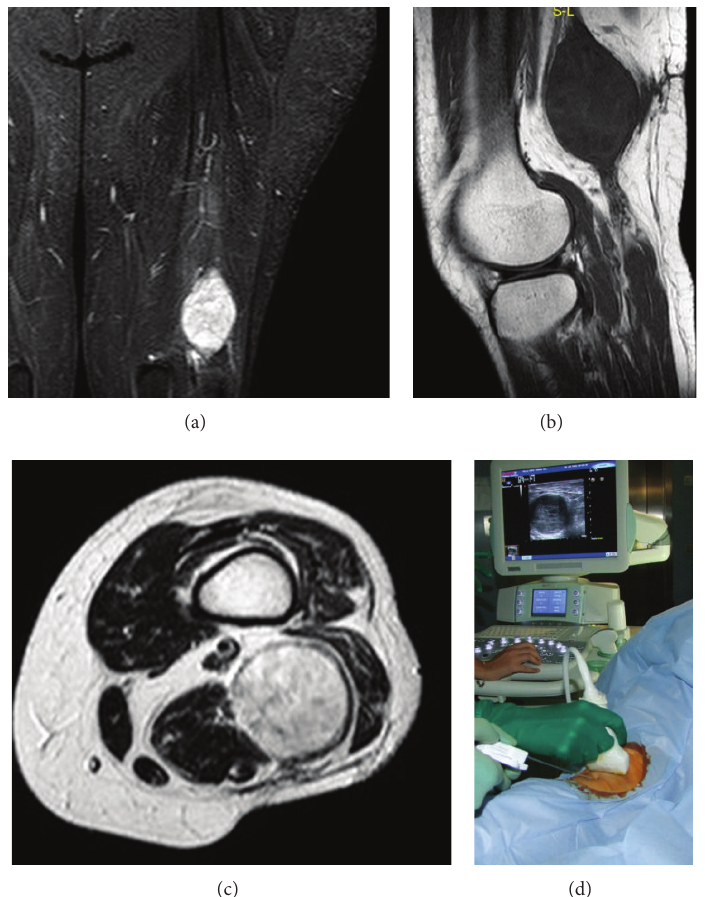
Figure 3: Coronal MRI STIR (a), sagittal MRI T2 (b), and axial MRI T1 (c) scans of the left thigh show homogeneous intratumoral hypointensive signal on T1 and hyperintensive signal on T2. A 14-gauge ultrasound-guided soft tissue percutaneous biopsy (d) of the left tight. Diagnosis: